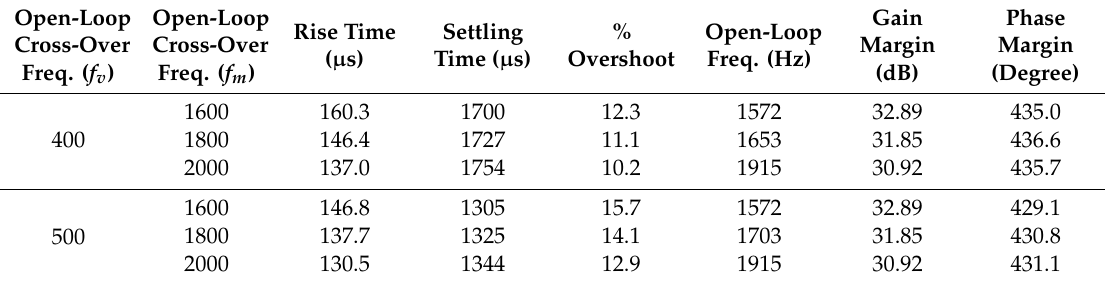
Table 2. Summary of the lag-lead controller as the primary controller and the lag filter as the secondary